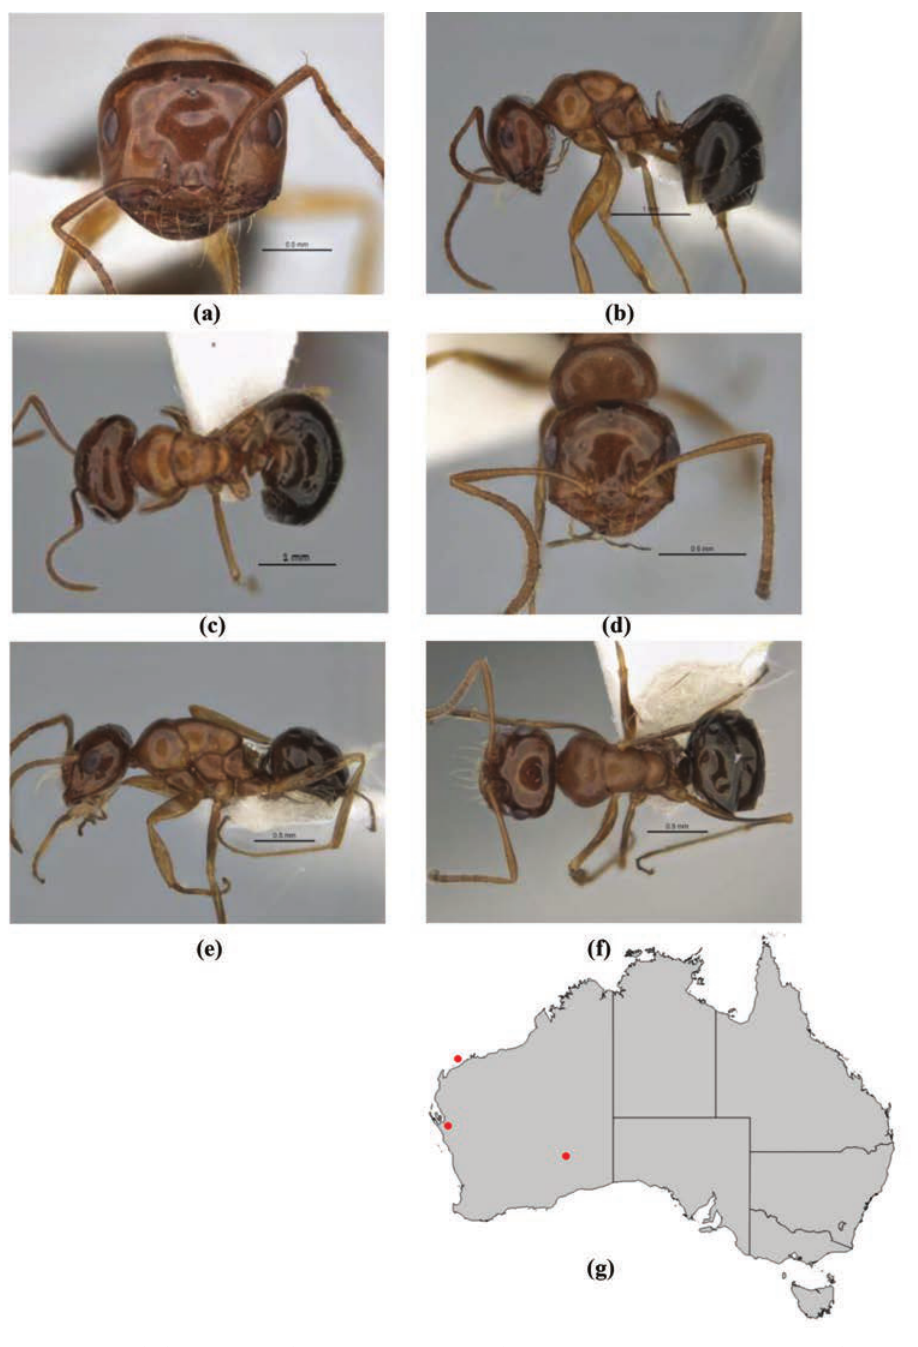
Figure 67. Melophorus paramorphomenus sp. n.: major worker paratype (JDM32-004561–top ant) frons ( a ), profile ( b ) and dorsum ( c ); minor worker holotype frons ( d ), profile ( e ) and dorsum ( f ); distribution map for the species ( g ). Low resolution scale bars: 1 mm ( b ); 0.5 mm ( a, d–f